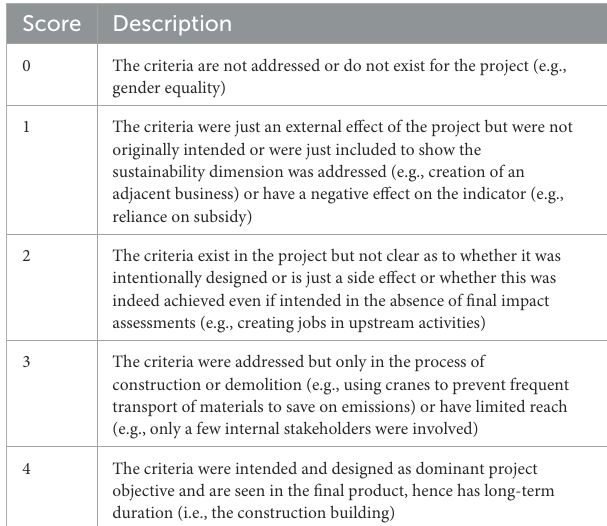
TABLE 2 Scoring system of the selected